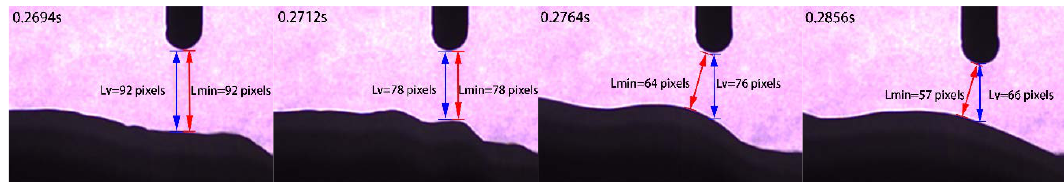
Figure 13. The relative position between the tip of the wire and the weld pool during base time (V = 13.75 cm/min).